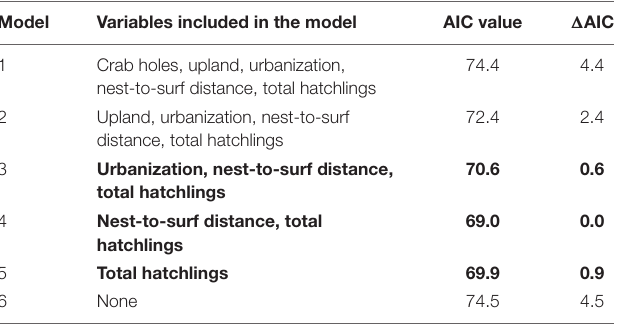
TABLE 4 | Results from GLMM model including variables from all locations. TABLE 5 | GLM results for each location, using StepAIC function in